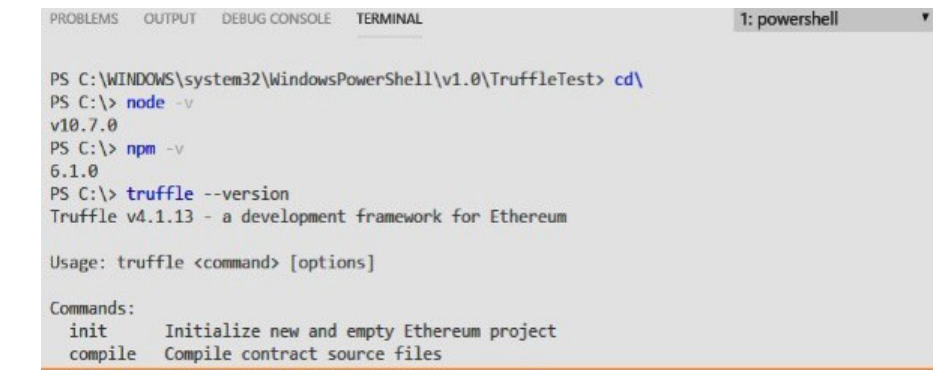
Figure 7. Node.js command prompt.